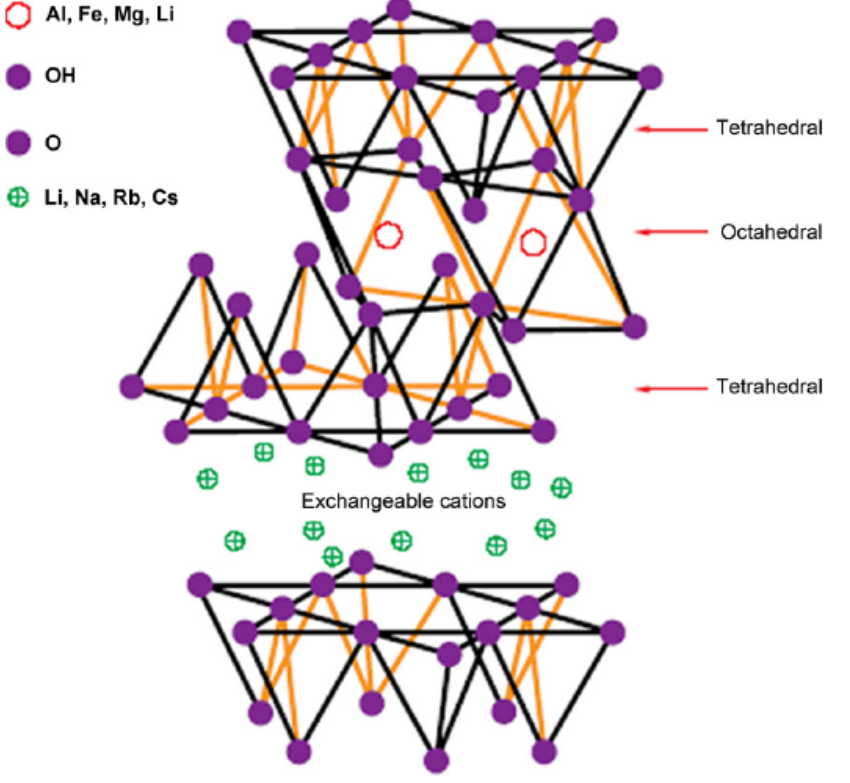
Figure 1. Structure of the 2:1 layered silicates. Reproduced from references [4] and [27] with permission from